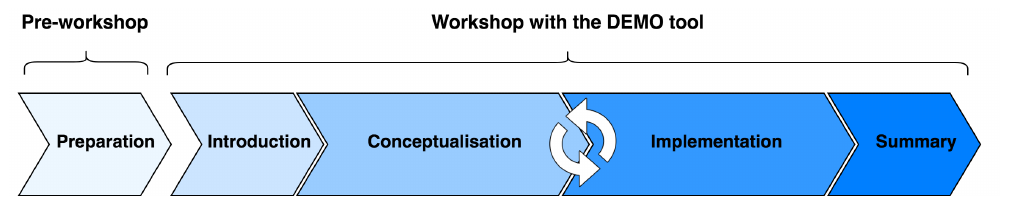
Figure 2. The design process of the DEMO